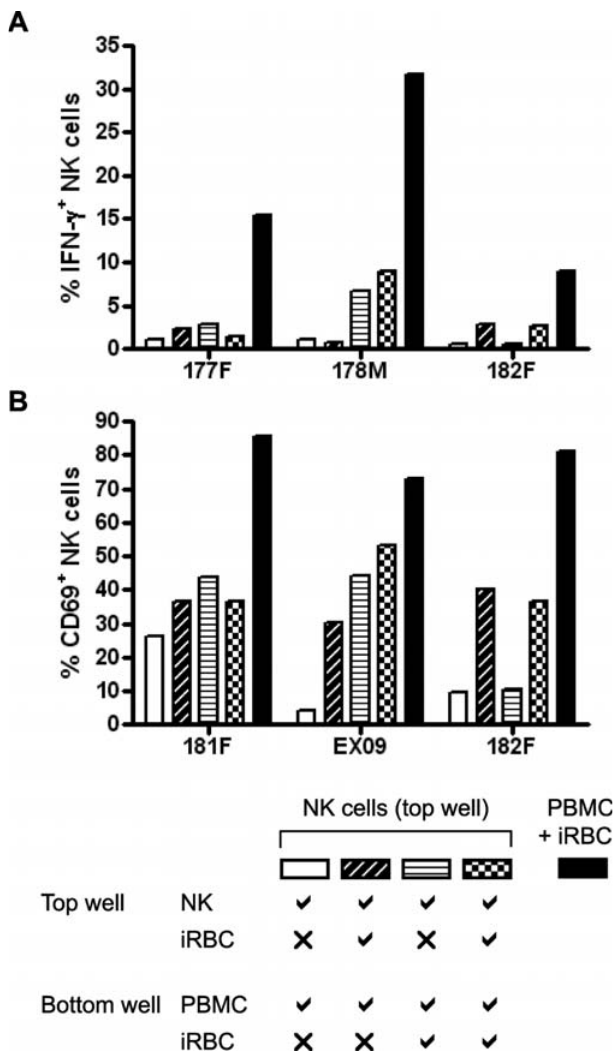
Figure 6. Contact between NK Cells and Accessory Cells Is Necessary for an Optimal Response to iRBCs Purified NK cells and autologous PBMCs were co-cultured in Transwell plates, separated by a microporous membrane. The presence of iRBCs in the respective compartments, purified NK cells in the top well and PBMCs in the bottom well are indicated in the key to the figure. Intracellular production of IFN- c (A) and surface expression levels of CD69 (B) on NK cells in the top well were analysed by flow cytometry. The black bars represent NK cell responses for PBMCs stimulated with iRBCs. All other bars represent values for purified NK cells (upper well). Percentages indicate the proportion of CD3 (cid:1) CD56 þ NK cells that were positive for IFN- c ; data are based on the collection of 100,000